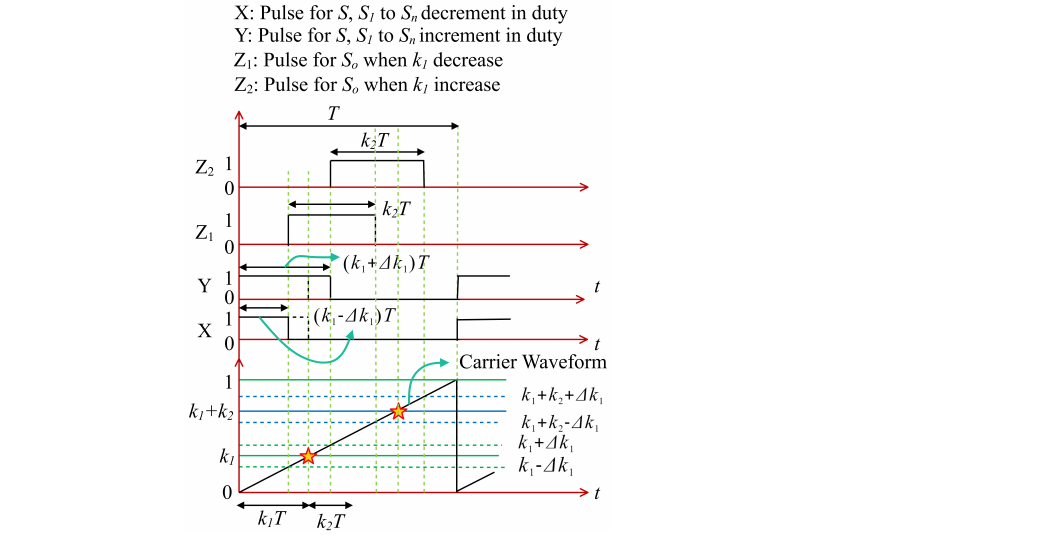
Figure 13. Control scheme-2, (X: variation in the duty cycle of switches S , S 1 − S n , when voltage is increased at the input side, Y: variation in the duty cycle of switches S , S 1 − S n , when voltage is decreased at the input side, Z 1 : the fixed duty cycle of switch S o is shifted when the voltage is increased at the input side, Z 2 : the fixed duty cycle of switch S o is shifted when voltage is decreased at the input side).